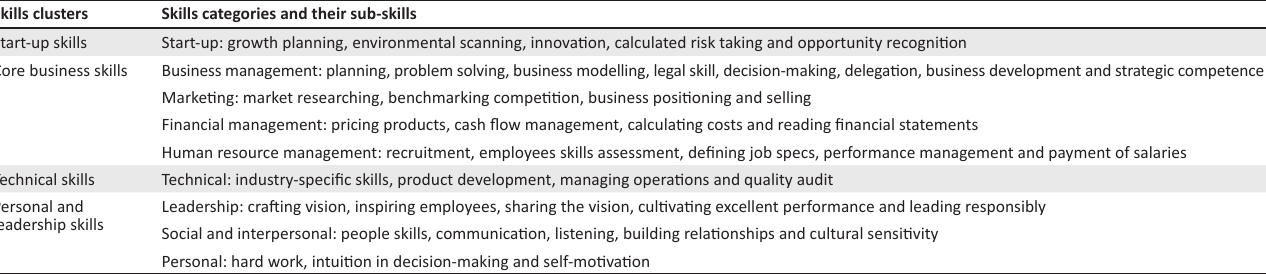
TABLE 5: Summary of skills from quantitative